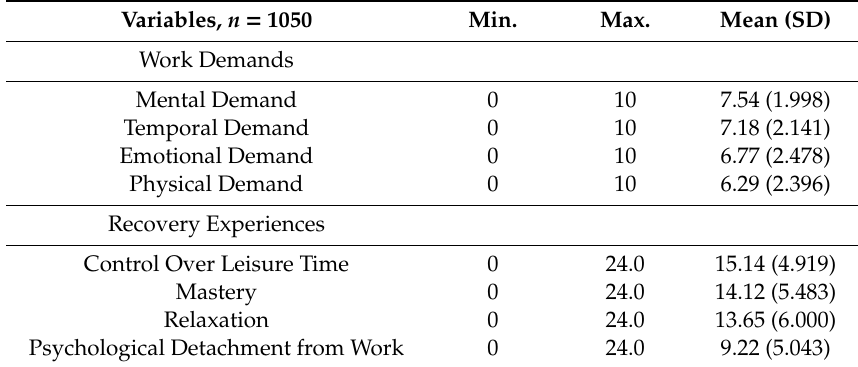
Table 3. Work demands and recovery experiences profiles